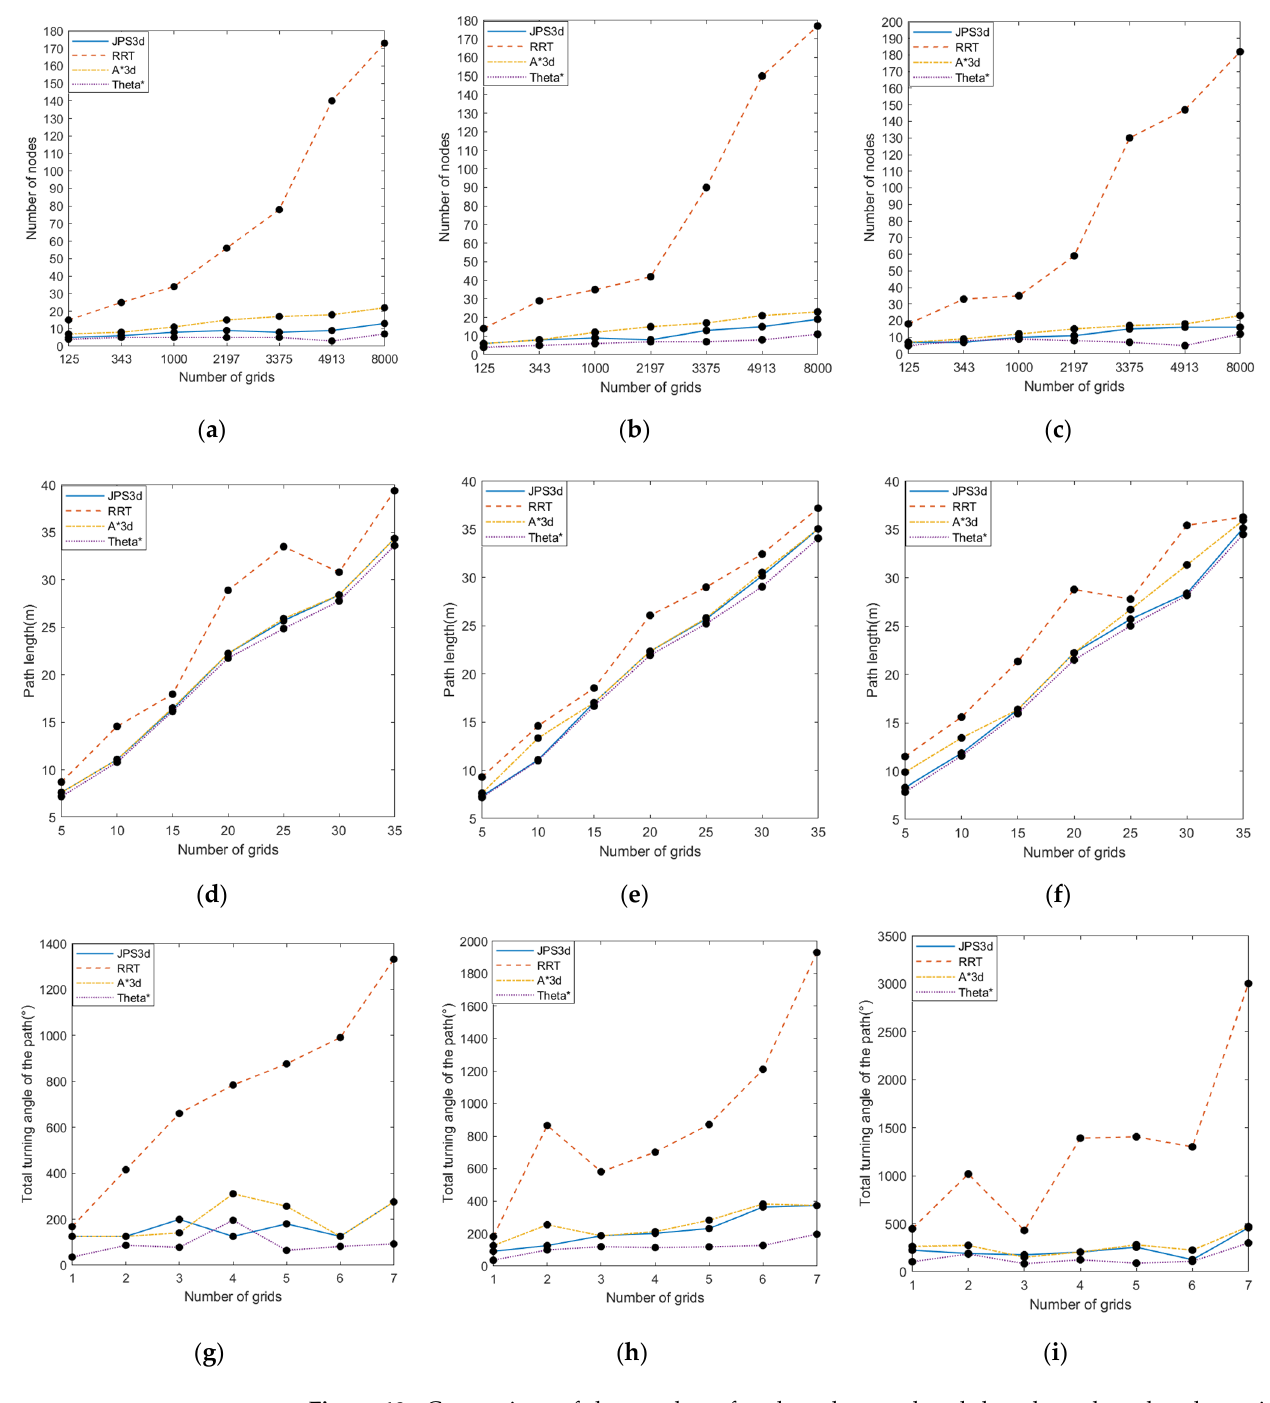
Figure 18. Comparison of the number of path nodes, total path length, and total path ‐ turning angle. ( a ) Comparison of the number of path nodes based on 20% obstacle ‐ occupied maps. ( b ) Comparison of the number of path nodes based on 30% obstacle ‐ occupied maps. ( c ) Comparison of the number of path nodes based on 40% obstacle ‐ occupied maps. ( d ) Total path length based on 20% obstacle ‐ occupied maps. ( e ) Total path length based on 30% obstacle ‐ occupied maps. ( f ) Total path length based on 40% obstacle ‐ occupied maps. ( g ) Total turning angle of the path based on 20% obstacle ‐ occupied maps. ( h ) Total turning angle of the path based on 30% obstacle ‐ occupied maps. ( i ) Total turning angle of the path based on 40% obstacle ‐ occupied maps.